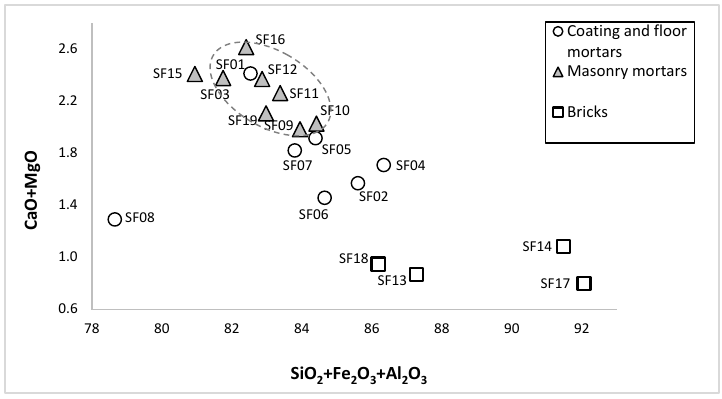
Figure 5. Mortars and bricks CaO + MgO vs. SiO 2 + Fe 2 O 3 + Al 2 O 3 binary diagram. The binary diagram TiO 2 /Fe 2 O 3 vs. SiO 2 /CaO showed a homogeneous group com- posed of MM samples, with low SiO 2 /CaO ratio, differing from CFM samples with lower TiO 2 /Fe 2 O 3 ratio and bricks with higher SiO 2 /CaO ratio (Figure 6). The similar TiO 2 /Fe 2 O 3 ratio (0.16–0.17%) of the CFM (SF04, SF07, SF08 and SF06) samples from the V to VII cen-